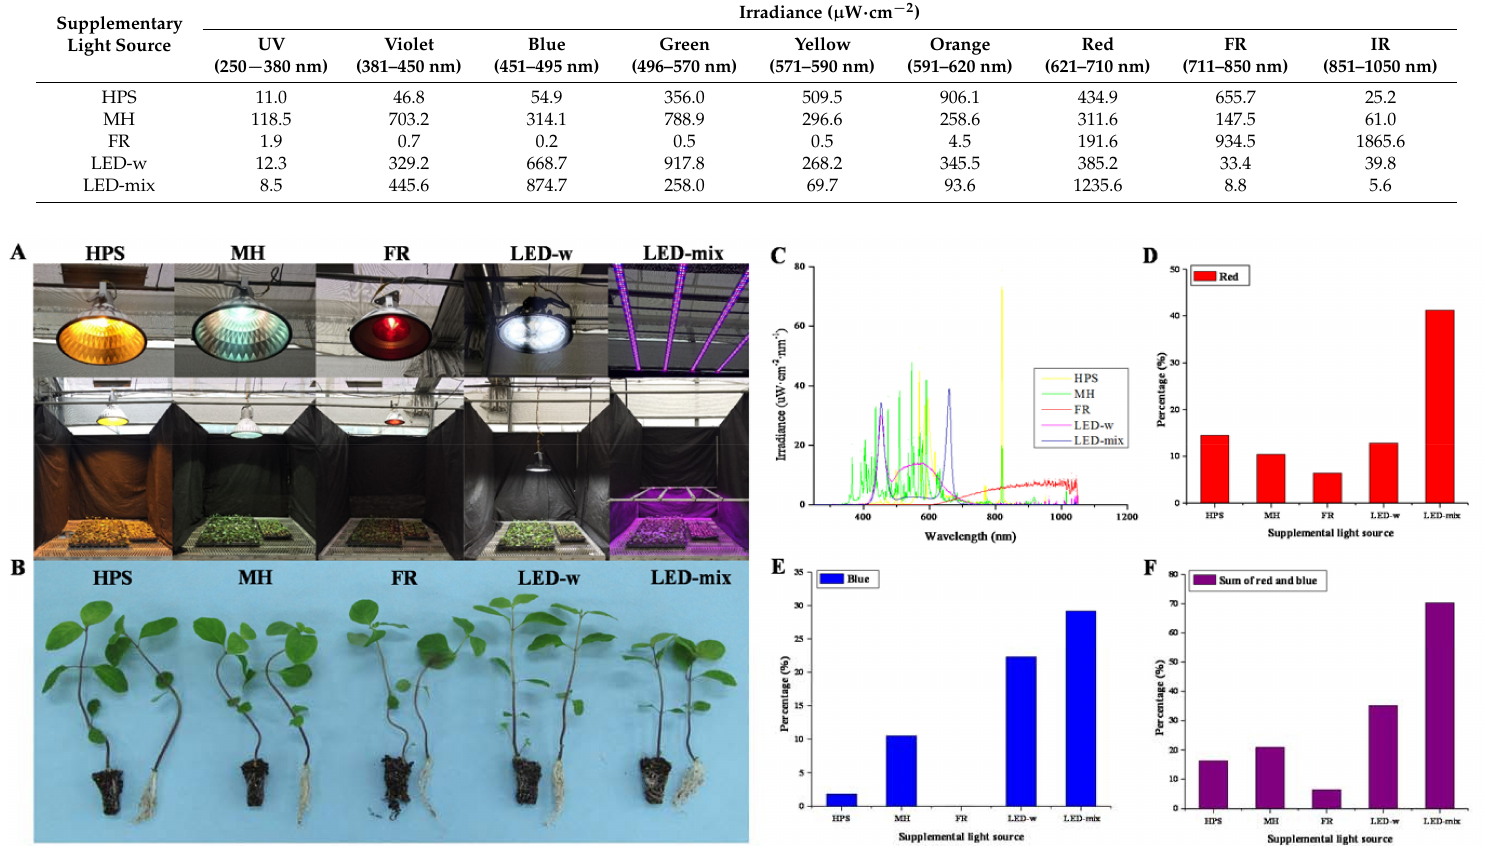
Figure 1. Supplementary light sources ( A ), the morphology of Codonopsis lanceolata seedlings affected by the supplementary light sources ( B ), spectral analysis of the high-pressure sodium (HPS, plotted in yellow), metal halide (MH, plotted in green), Far-red light (FR, plotted in red), white light emitting diode (LED-w, plotted in rosy red), and a mixture of red, blue, and white LED (LED-mix, plotted in blue) each at a total irradiance of 3000 µ W · cm − 2 ( C ), and the percentage of red and/or blue light irradiance ( D – F